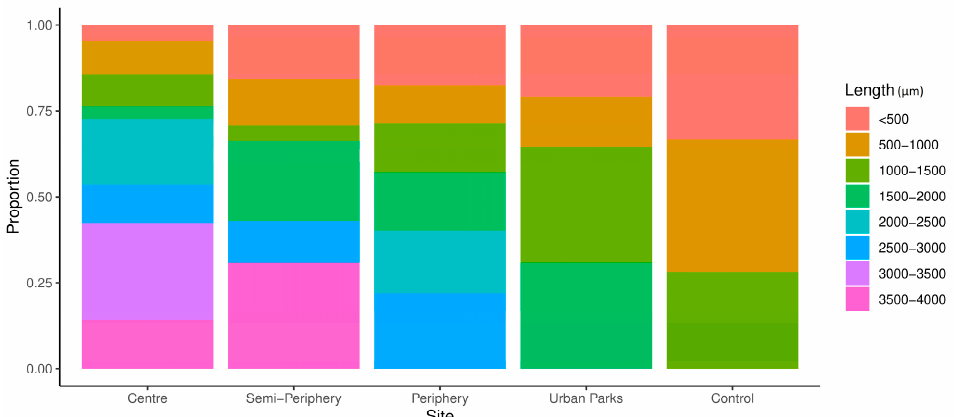
Figure 2. Fractional distribution of the length ( µ m) of microfibres (n = 141) across the four urban sampling zones in Milan and the background control site in northern Italy.